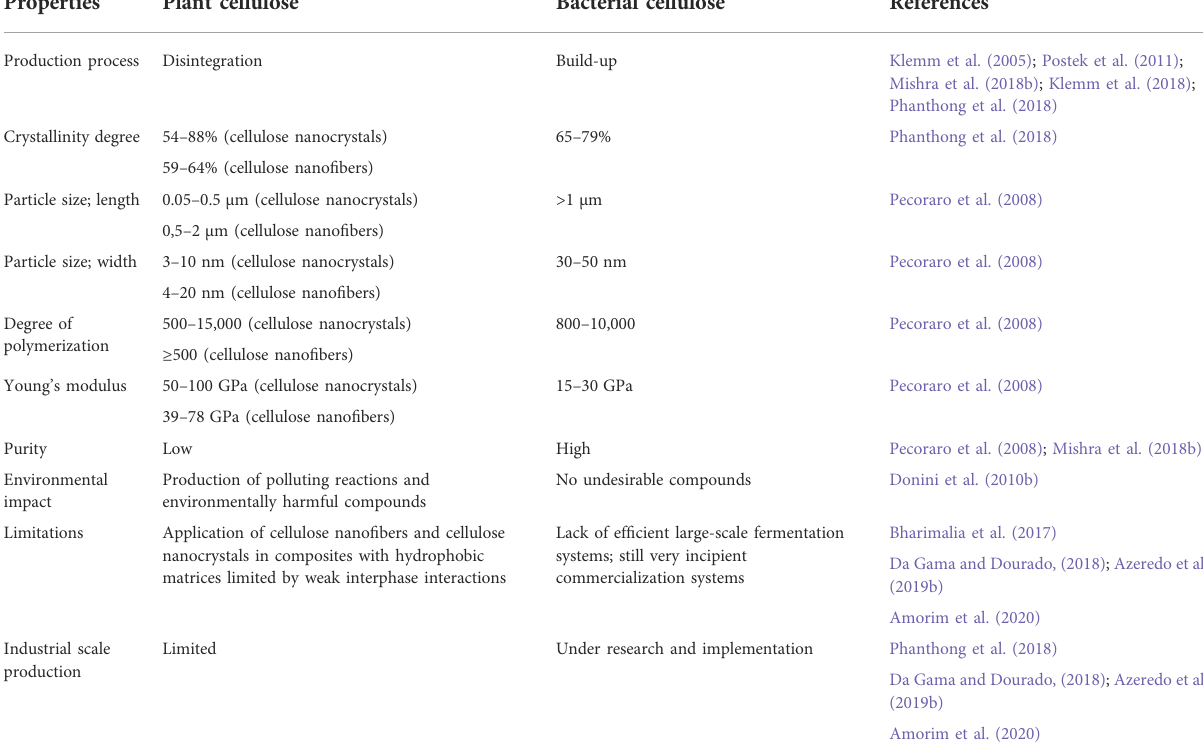
TABLE 2 Comparison of properties between plant and bacterial